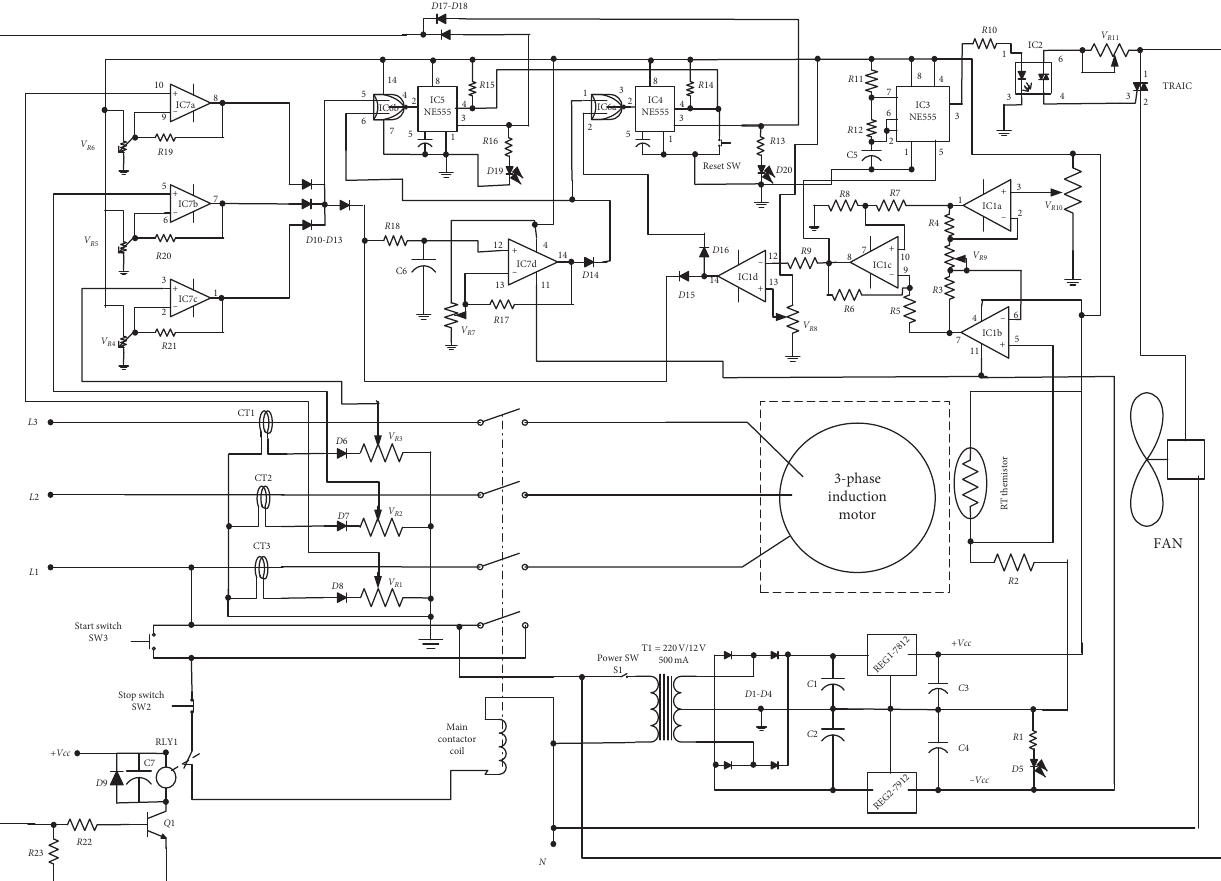
Figure 8: The complete circuit diagram of the